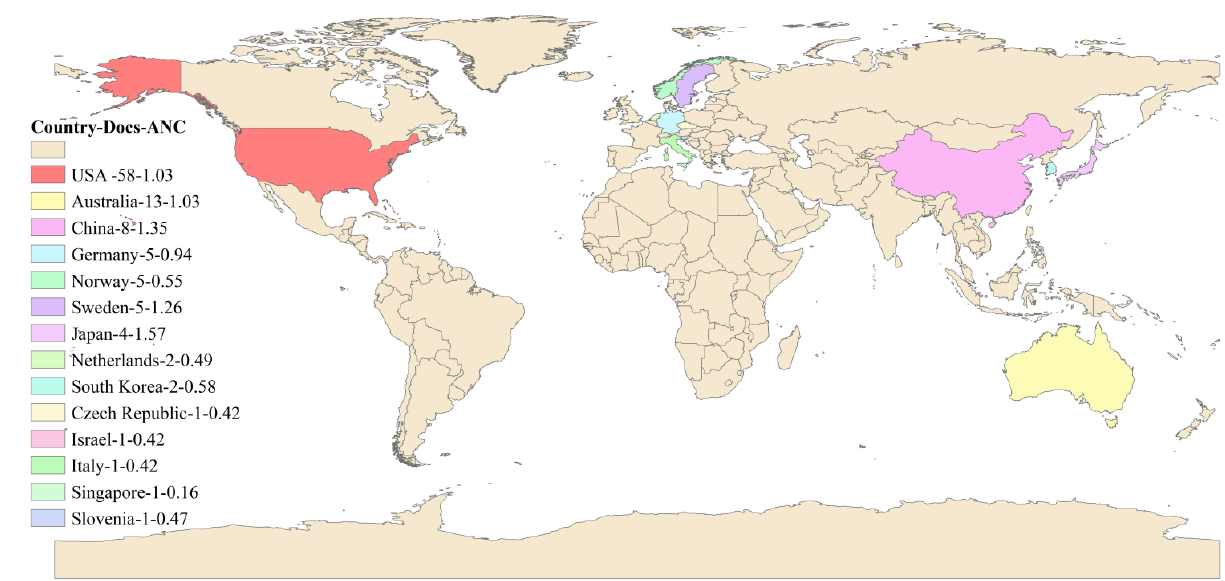
Figure 7. The geographical map of countries actively engaged in the research topic. Table 3 provides more quantitative measurement data, including the number of publi- cations, mutual citations, the average publication year, the total number of citations, the average number of citations, and the average number of normalized citations. According to Table 3, the USA, Australia and China have both the most significant number of pub- lications and the most extensive citation according to the average number of normalized citations, and Portugal, Japan, Switzerland, and China show the strongest influence in this research field.